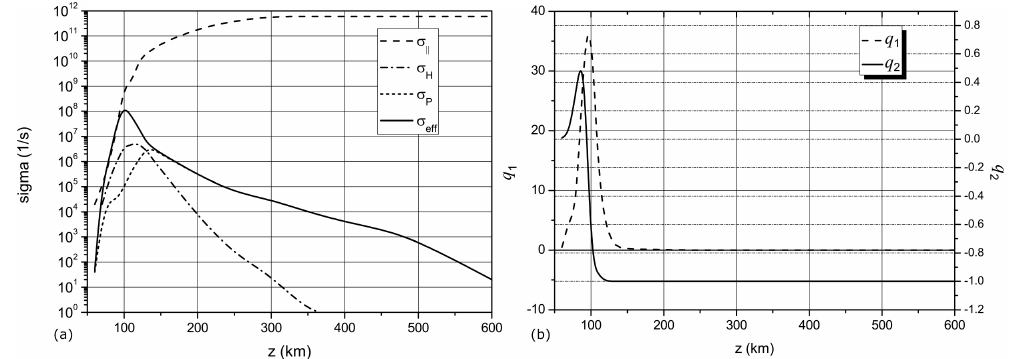
Fig. 2. The dependence of ionosphere conductivities σ 0 , σ H , σ P and σ eff as a function of height, z , are shown in (a) . The values of coefficients q 1 , 2 vs. height, z , are plotted at (b) . q 1 and q 2 are coefficients in the expressions, corresponding to the “transverse” electric field, determined by Hall current and “longitudinal” electric field (see Eq.